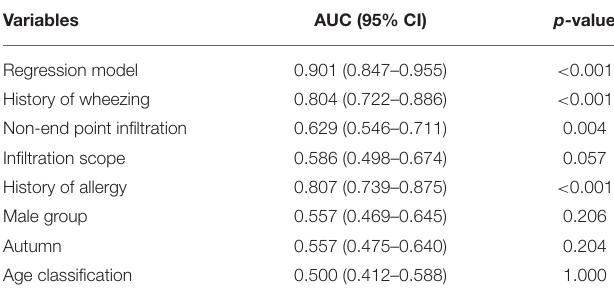
TABLE 6 | Area under the curve (AUC) of the multiple logistic regression model and the single univariate variable as predictors of wheezing in children with MP